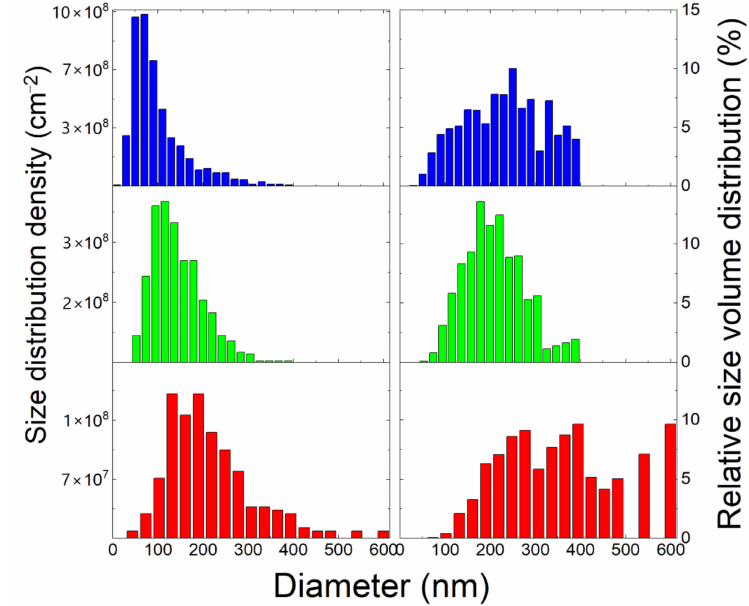
Figure 3. Left panels: size distribution density of sample S4 ( top ), S5 ( center ) and S6 ( bottom ). Right Panels: size distribution of the relative volume (in percent) of sample S4 ( top ), S5 ( center ) and S6 ( bottom ).